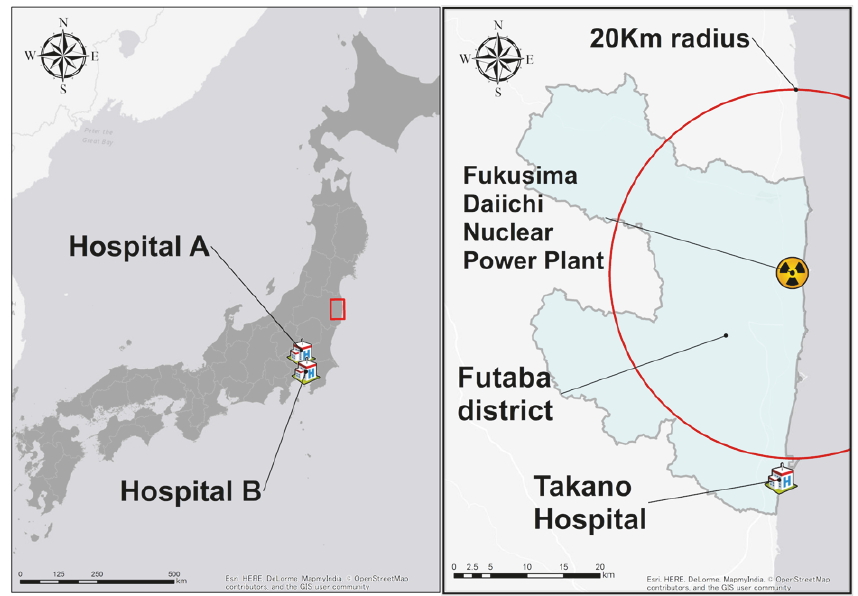
Figure 1: Map of Takano Hospital, Hospital A, and Hospital B. Takano Hospital is located 22 km south of Fukushima Daiichi Nuclear Power Plant. Hospitals A and B are located 250 km and 255 km south of Takano